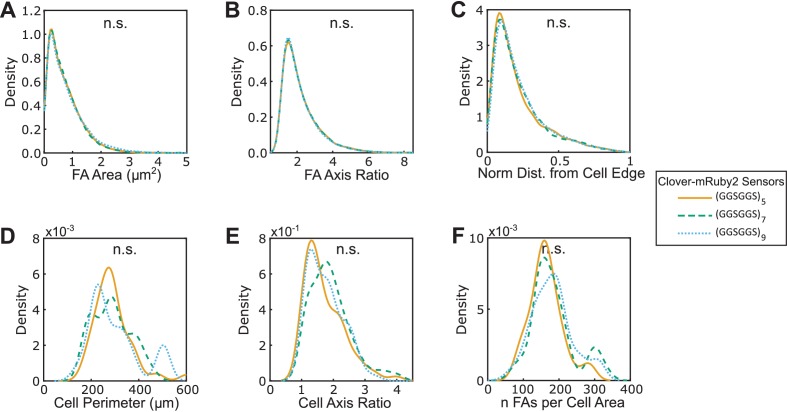
Three versions of VinTS respond similarly to Y-27632 treatment.(A-F) Vin-/- MEFs expressing various version of VinTS, treated with Y-27632, show indistinguishable FA area (A), FA axis ratio (B), subcellular distributions of FAs quantified as normalized distance from cell edge (C), cell perimeter (D), cell axis ratio (E), number of FAs normalized by cell area (F). Different versions of the tension sensor were constructed with minimal Clover-mRuby2 modules flanking three distinct extensible domains, namely (GGSGGS)5 (n = 50 cells), (GGSGGS)7 (n = 40 cells), (GGSGGS)9 (n = 42 cells), pooled from three independent experiments; n.s. not significant (p≥0.05), ANOVA. See Supplementary file 4 for exact p-values.